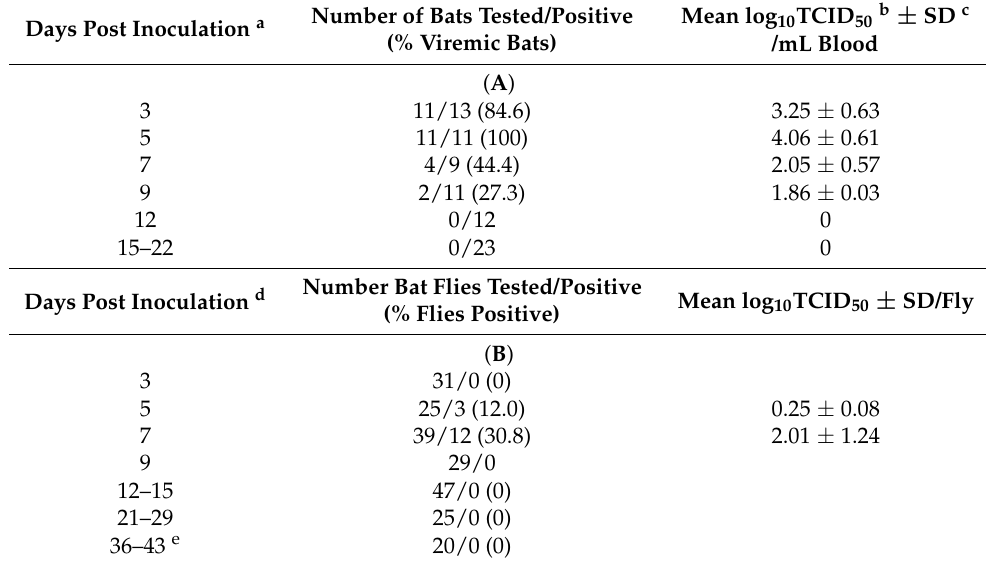
Table 4. Experiment 1. Quantitative reverse-transcription PCR (RT-PCR) results in captive-bred Rousettus aegyptiacus inoculated subcutaneously with Marburg virus (MARV) ( A ) and in bat flies fed on MARV-inoculated bats ( B ). Number of Bats Tested/Positive Mean log 10 TCID 50 b ± SD Days Post Inoculation a (% Viremic Bats)